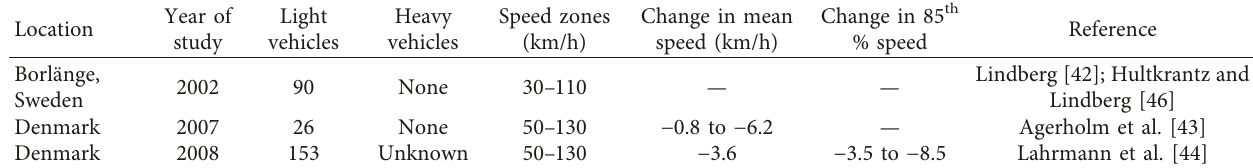
Table 1: The summary results of the recent advisory trial study in some countries with